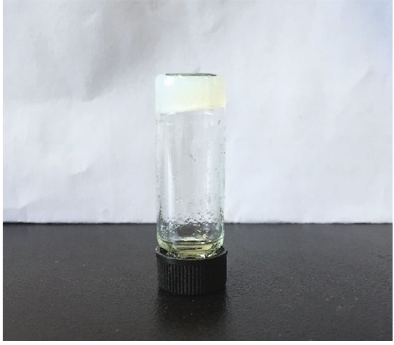
Figure 11: Macroscopic view of P2 forming a gel in